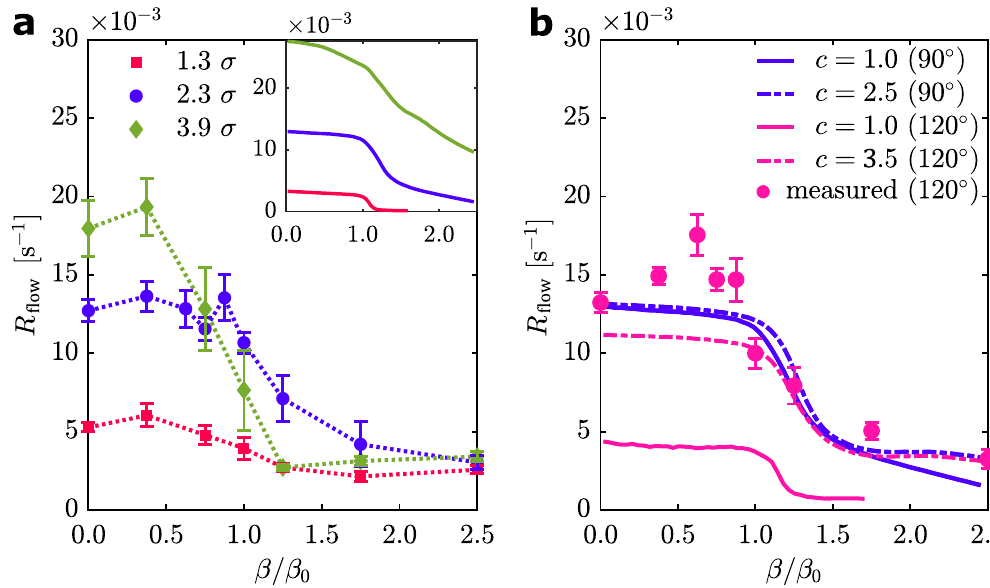
Figure 4. Flow rate. ( a ) Flow rate R flow at a bottleneck with θ = 90 ◦ and varying d . Experimental (data points connected by dashed lines) and simulated (inset) data. The error bars correspond to the standard deviation of mean of the single measurements. ( b ) Simulated flow rate at a bottleneck with d = 2.3 σ and θ = 90 ◦ or θ = 120 ◦ . The prefactor of the simulated effective temperature c is varied (dashed and straight lines). The datapoints are the experimental results for a bottleneck with d = 2.3 σ and θ = 120 ◦ . The error bars correspond to the standard deviation of mean of the single